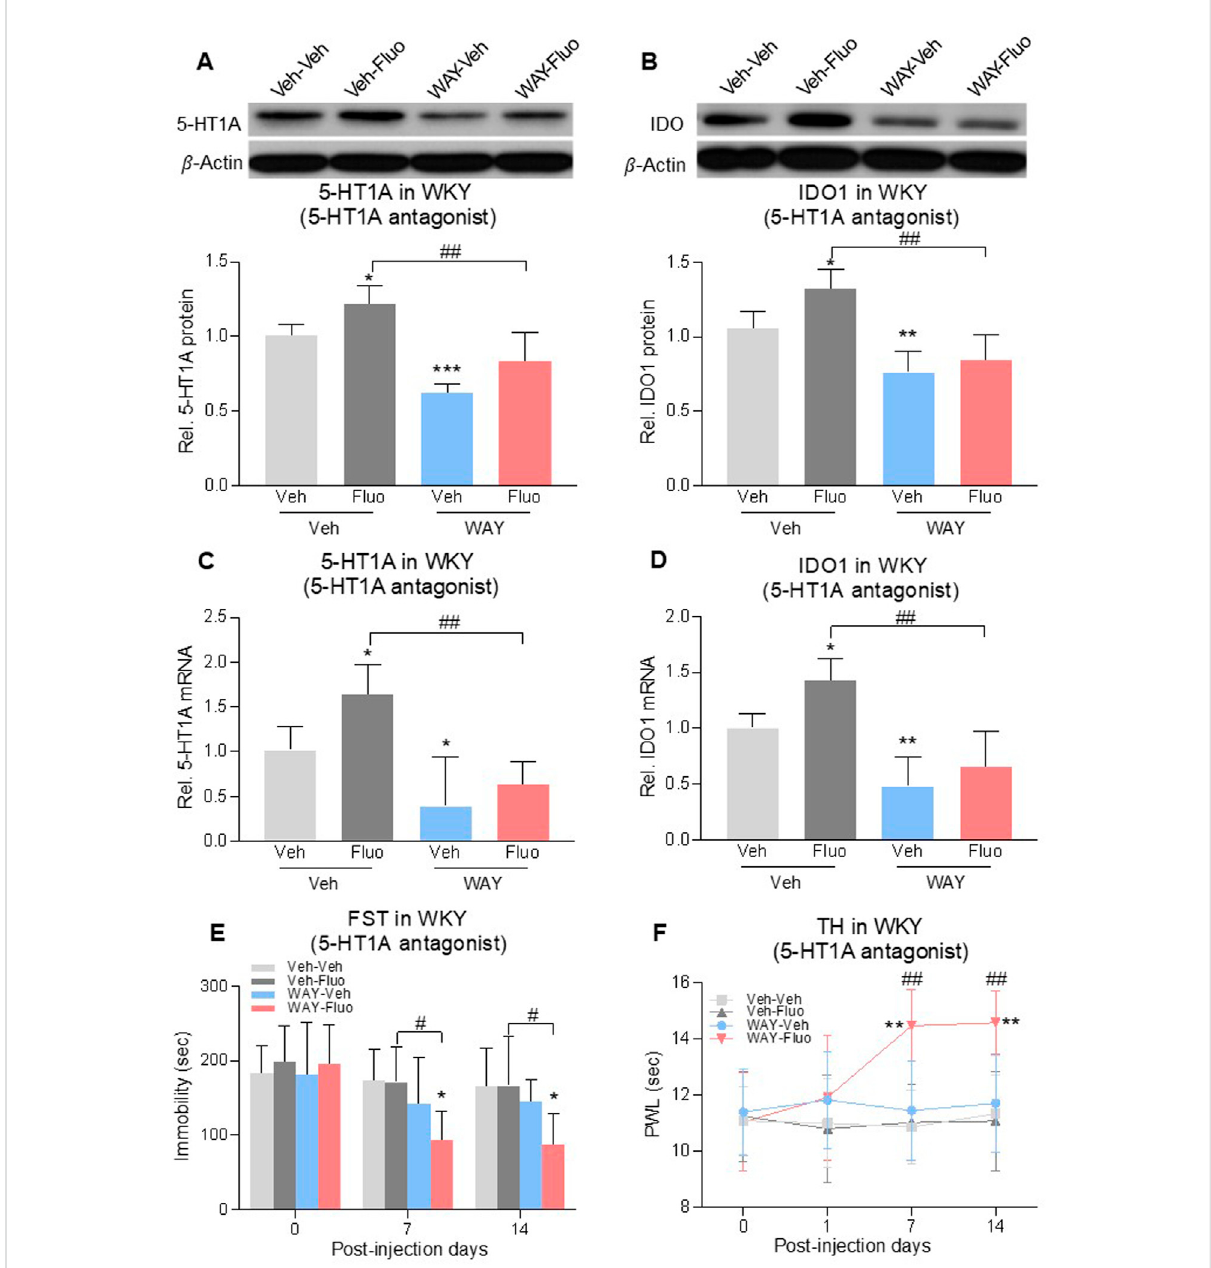
FIGURE 4 Intra-DRN 5-HT1A receptor antagonist restored the fl uoxetine effect in WKY rats. 5-HT1A receptors and IDO1 protein (A,B) and mRNA (C,D) expressioninDRNofWKYratswereincreasedby fl uoxetine(Veh-Vehvs.Veh-Fluo)butreversedbyaddingintra-DRNWAY(Veh-Fluovs.WAY-Fluo). Fluoxetinemaintenancetreatmentcombinedwithintra-DRNWAYinjection(Veh-Vehvs.WAY-Fluo,Veh-Fluovs.WAY-Fluo),butnotwith fl uoxetine or WAY alone (Veh-Veh vs. Veh- Fluo or WAY-Veh), decreased immobility time in FST (E) and increased PWL in TH (F) from day 7 – 14. The data are presented as mean ± SD ( n = 6). * p < 0.05, ** p < 0.01 and *** p < 0.001 vs. Veh-Veh; # p < 0.05 and ## p < 0.01, Veh-Fluo vs. WAY-Fluo. Rel. Indicates relative; Veh, vehicle; Fluo, fl uoxetine; WAY, WAY100635; FST, forced swim test; TST, tail suspension test; TH, thermal test; PWL, paw withdrawal